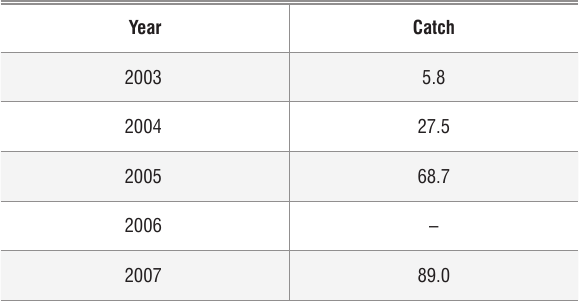
Estimates (tonnes) of illegal abalone catch, 2003–2007